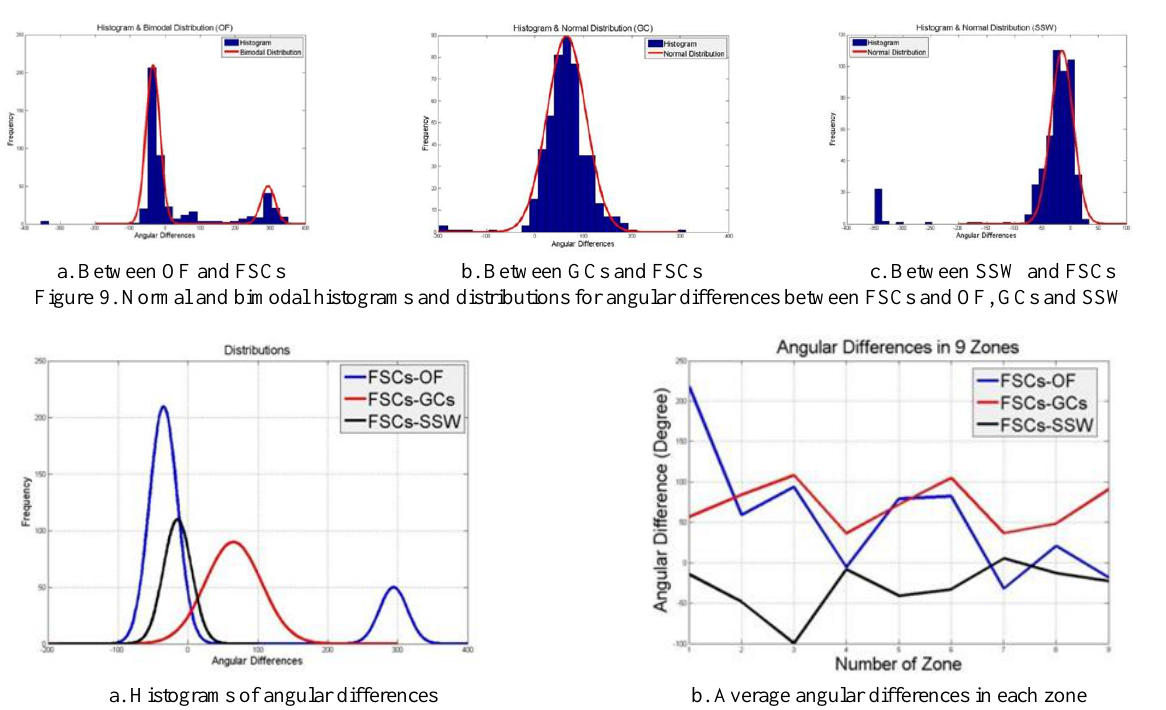
Figure 10. The blue, red and black lines are respectively about angular differences between OF, GCs and SSW with FSCs